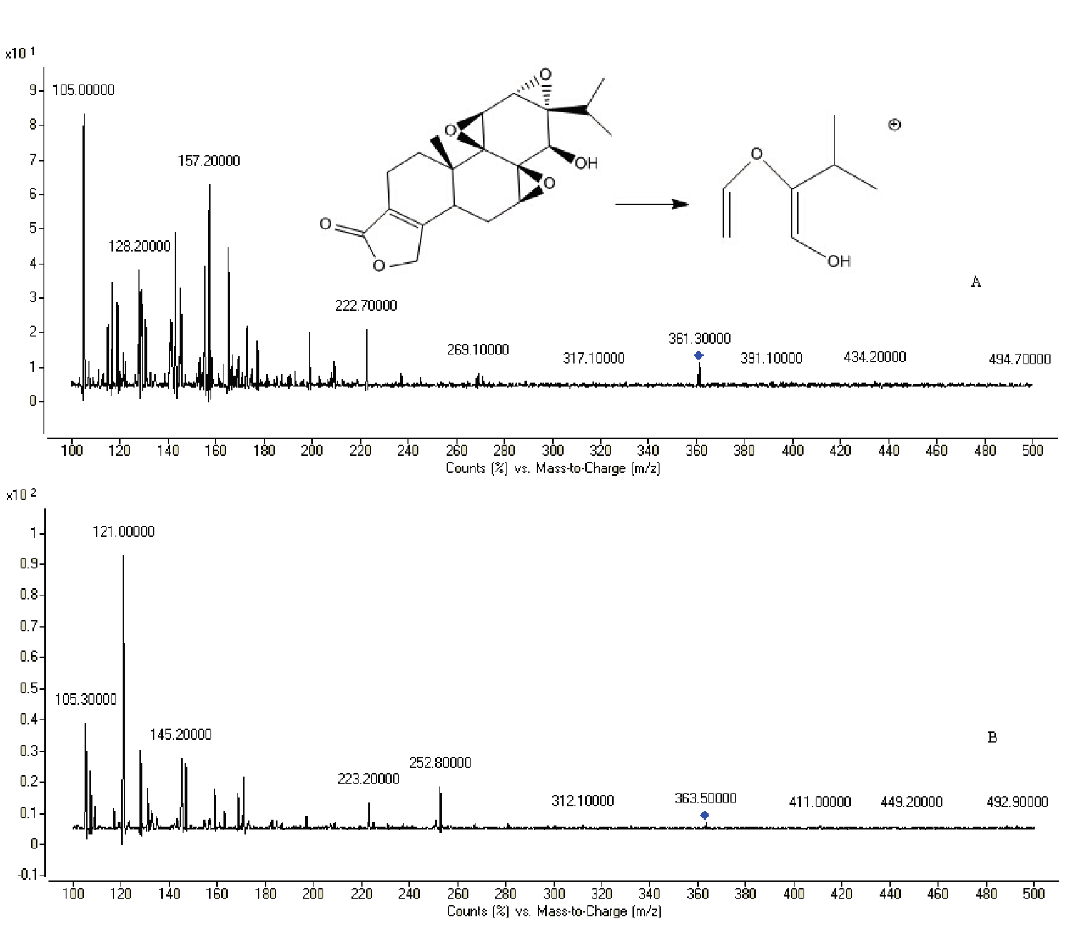
Figure 1. The mass spectra of triptolide ( A ) and IS ( B ).